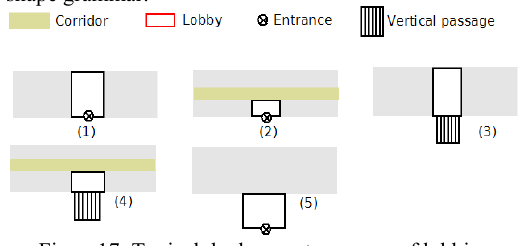
Figure17. Typical deployment manners of lobbies